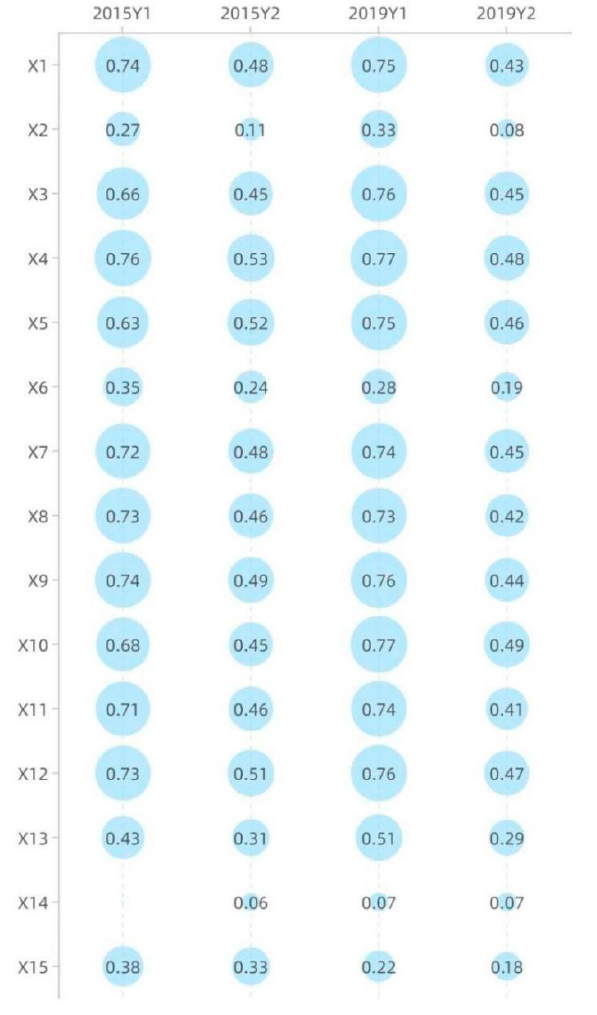
Figure 5. The q-value of the factor detector result.